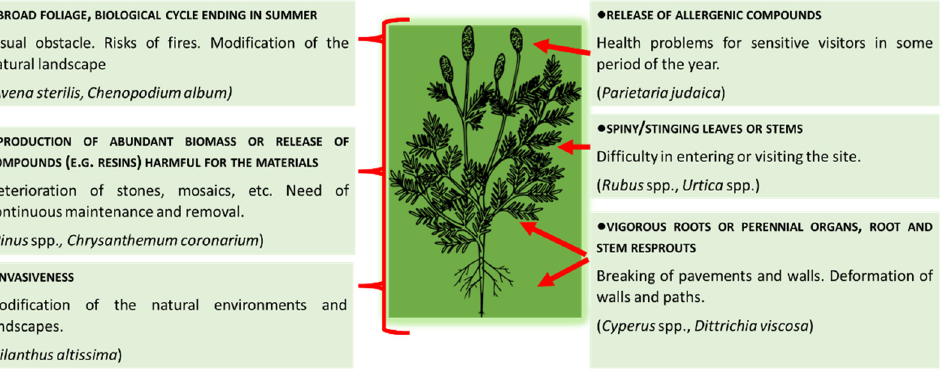
Figure 1. Examples of hazards related to weed infestation (plant image from: https://www.iconspng.com/image/52924/western-burnet, accessed on 20 March 2022).